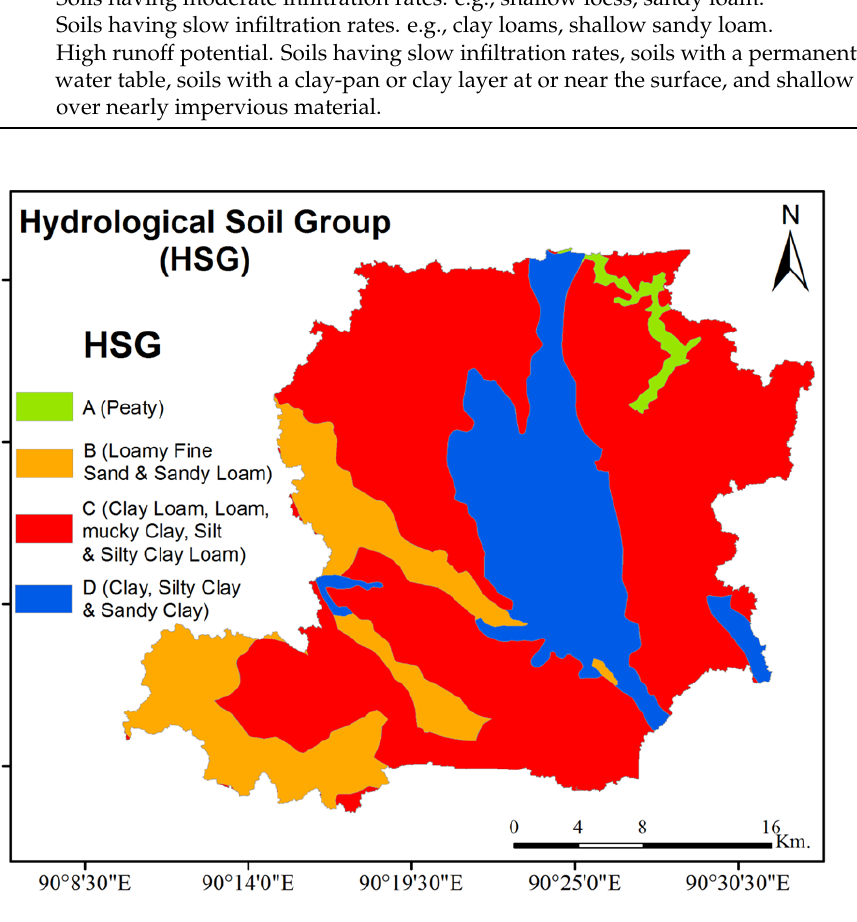
Figure 3. Classified HSG soil map; e.g., various HSG type soils (A,B,C, and D) represent the infiltration and runoff generations characteristics, HSG-A (sandy soils) having highest infiltration, thus least runoff potential, whereas HSG-D (clay type) has the least infiltration and highest runoff potential.